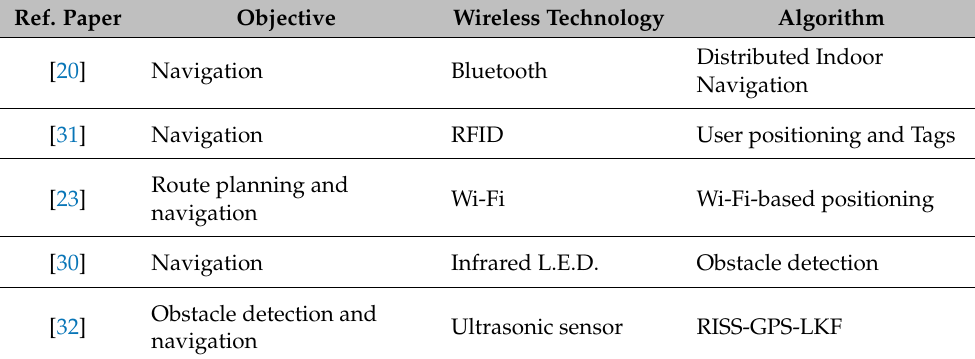
Table 3. Summary of Various Navigation Techniques.